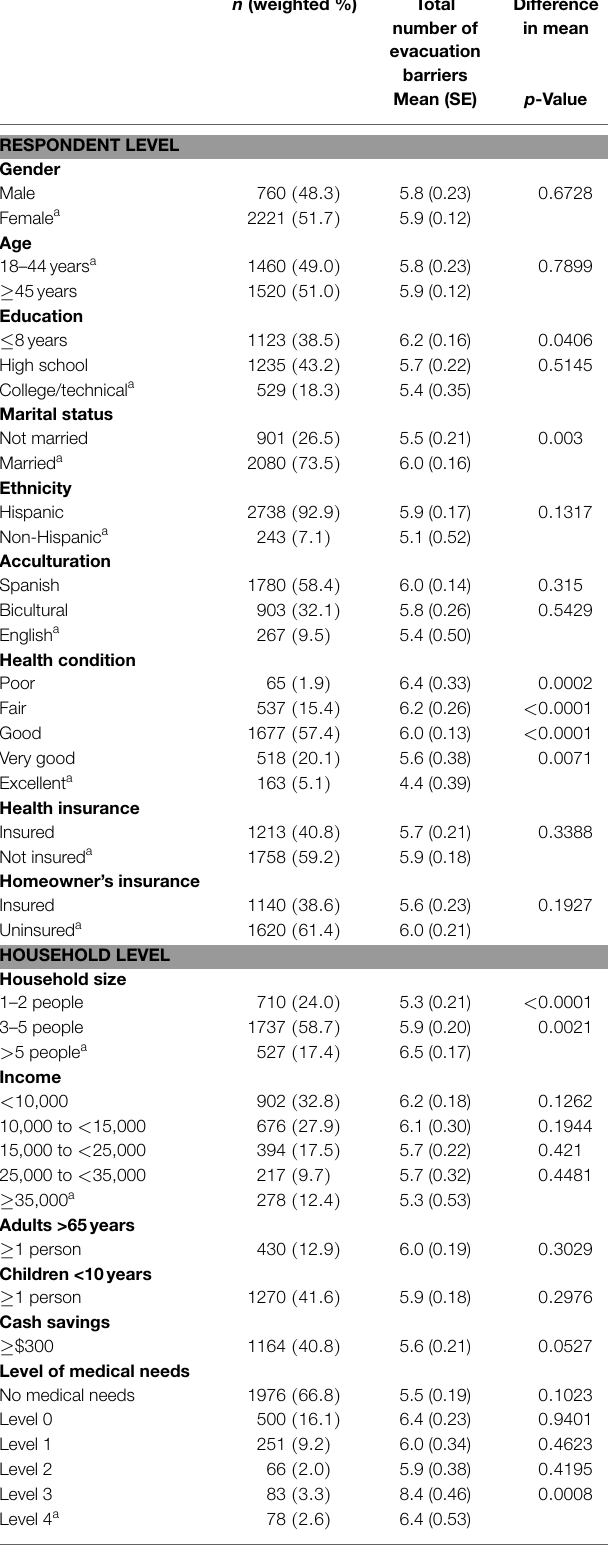
TABLE 2 | Demographics characteristics of respondents and households and reported barriers to evacuation ( n =2981) . n (weighted %) Total number